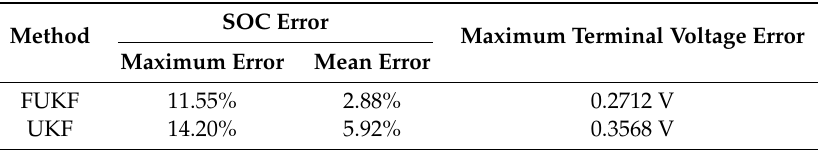
Figure 9. The results of dynamic discharge experiment. ( a ) The results of SOC estimation; ( b ) The errors of SOC estimation; ( c ) The results of battery terminal voltage estimation; ( d ) The errors of battery terminal voltage estimation; ( e ) The distribution of the estimation error. Table 2. Dynamic discharge experiment result